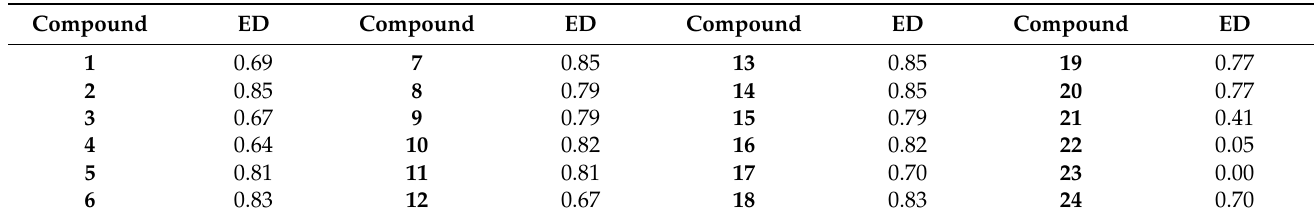
Table 7. The similarity parameter (ED) for the ADMET parameters and experimental lipophilicity for compounds 1 – 24